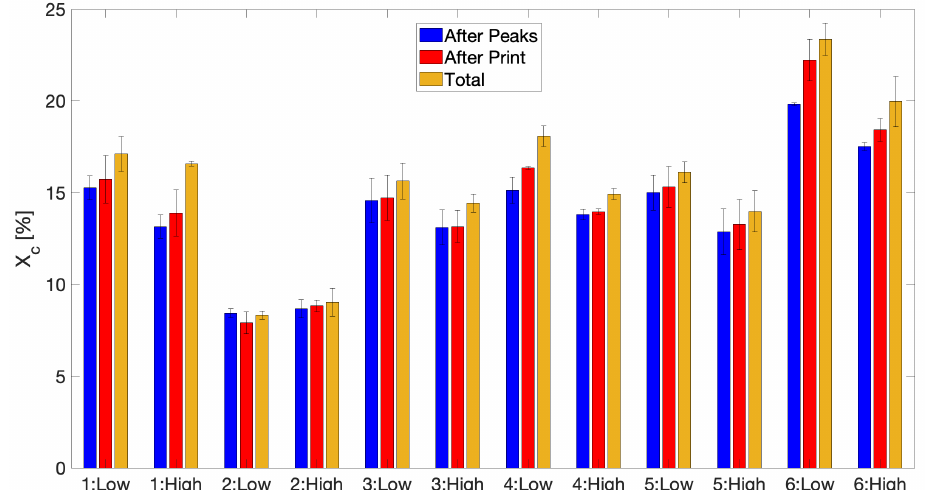
Figure A6. The resulting degrees of crystallinity from FSC measurements for printing conditions 1 to 6 as discussed in [54]. Error bars are added to indicate reproducibility. ‘Low’ and ‘High’ refer to layer 10 and 40,